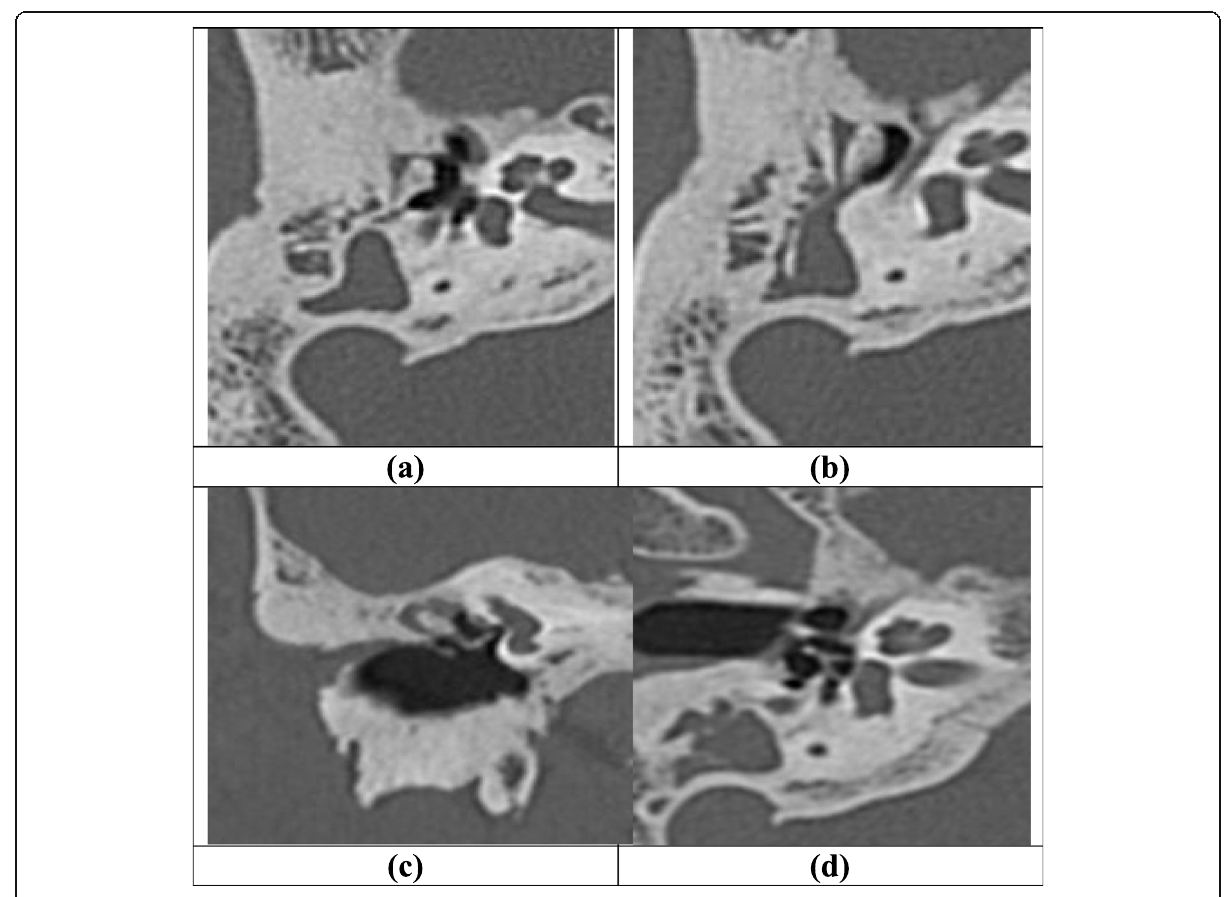
Fig. 6 Case 3: Type-II in non-cholesteatomatous CSOM. Type-II (pyramidal) is seen in a , and Köerner septum is seen in b , at the lateral margin of the opacified mastoid antrum. Curved multiplanar reformats reveal ossicular – V sign of intact incus body and process (This means the V-shaped appearance of the intact continuous incudo-stapedial junction is most susceptible to erosions). The stapes is well visualized in d with intact incudo-stapedial